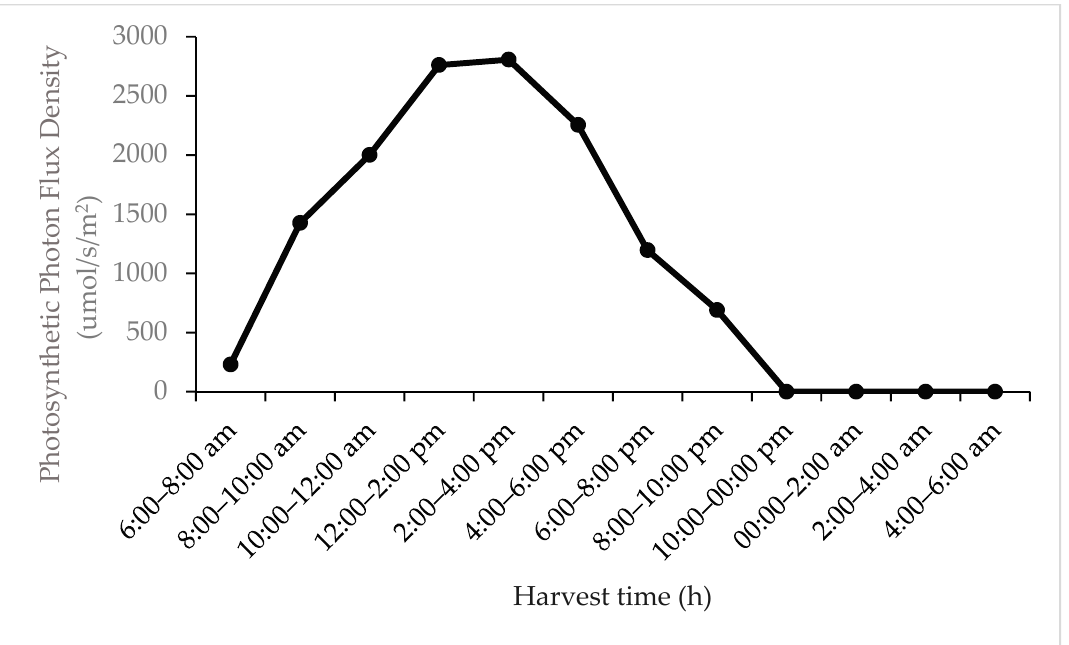
Figure 2. Averages of the light intensities during the collecting times of S. officinalis.